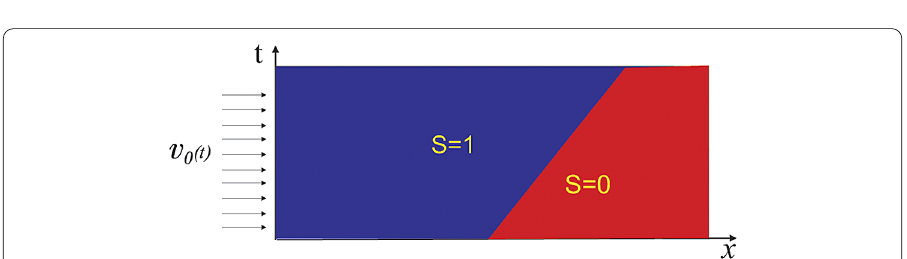
Figure 5 The solution of the Muskat problem. The free boundary separates two liquids and moves with a constant velocity.